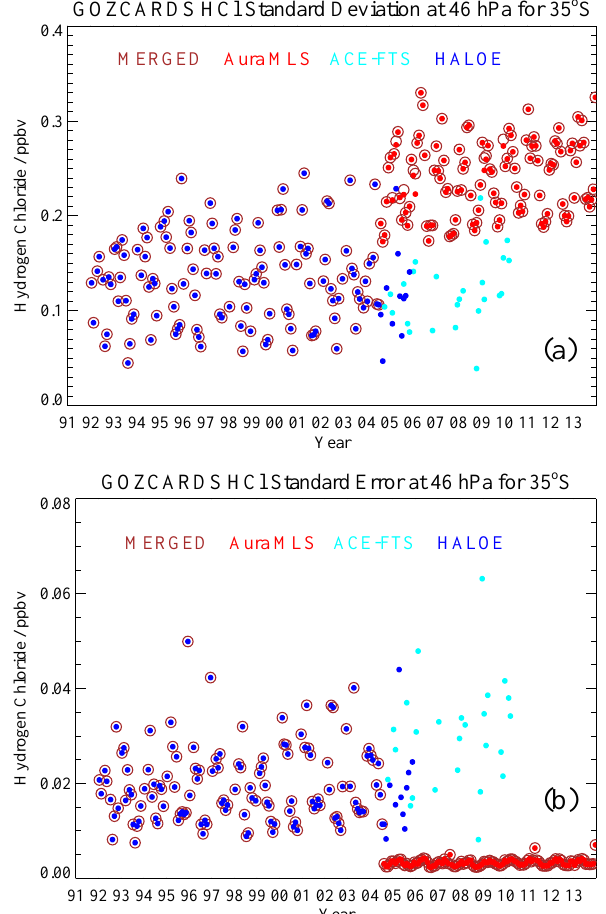
Figure A1. Illustration of the standard deviations (in a ) and stan- dard errors (in b ) for monthly mean GOZCARDS HCl (source and merged records) at 46hPa for 30–40 ◦ S. Source data from HALOE, Aura MLS, and ACE-FTS are given by the filled colored dots (see legend); each standard deviation is simply obtained from the range of values measured during the month. The large open brown circles give standard deviations for the merged HCl product; this Appendix provides the formulae to calculate these